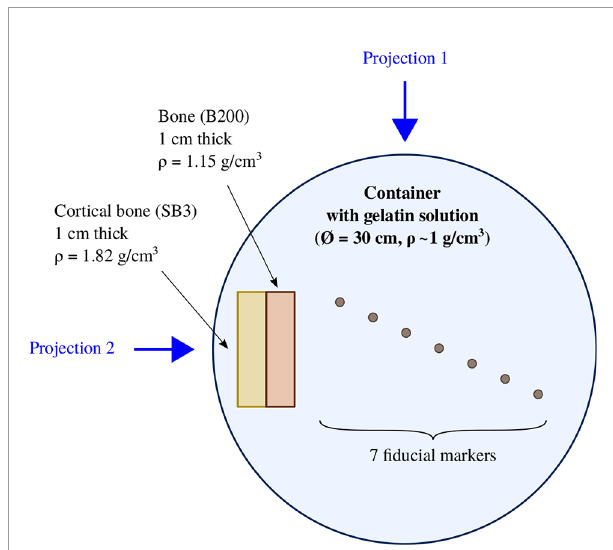
FIGURE 1 | Phantom used for the imaging study where 7 fi ducial markers were inserted inside a gelatin solution. Two bone-like slabs were placed on one side of the phantom.